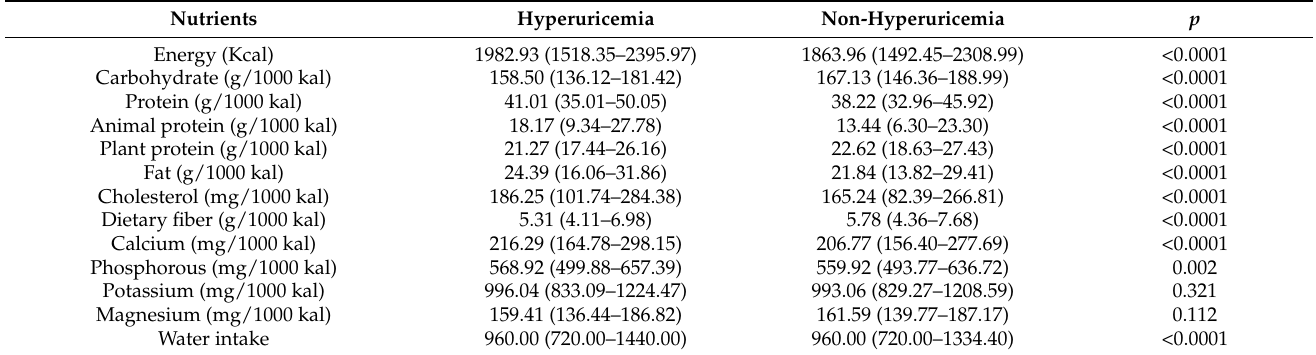
Table 2. Energy and nutrient intakes (energy-adjusted, per 1000